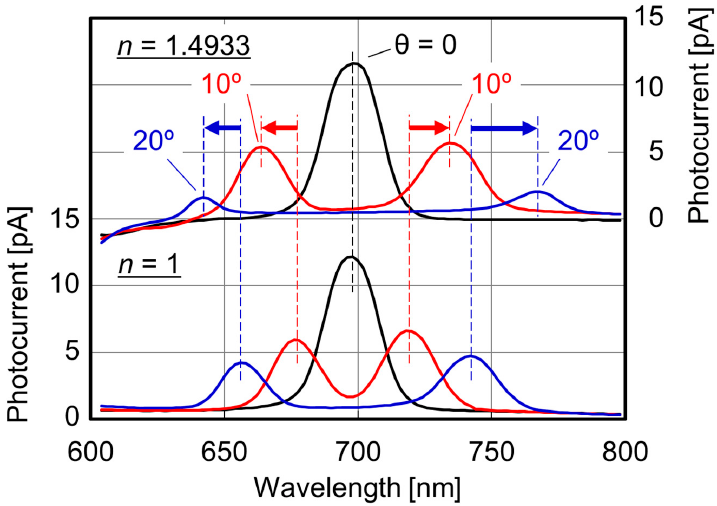
Figure 5. Measured spectroscopic photocurrent with various incident angle θ for two refractive indices. The period of surface plasmon (SP) antenna is p = 300 nm.